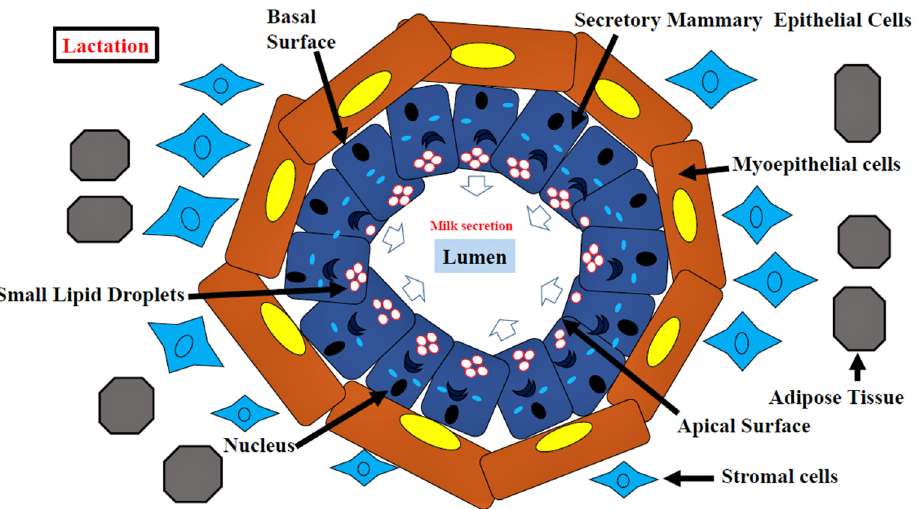
Figure 5. Schematic diagram illustrating the MECs in the lactating mammary gland. White arrows depict the direction of milk secretion from the apical surface of secretory epithelial cells.